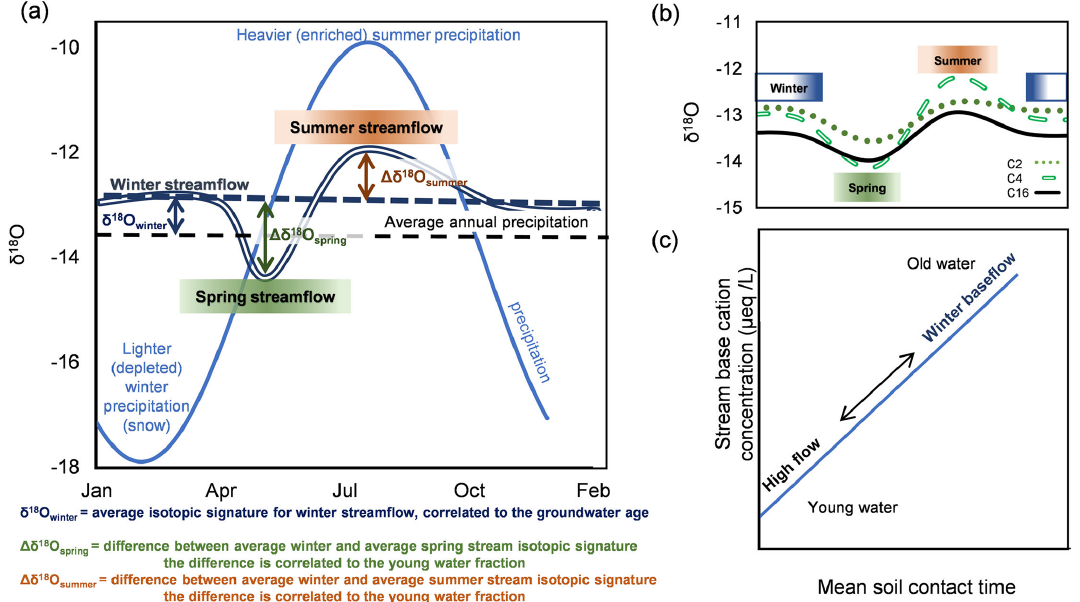
Figure 2. Conceptual figure of travel time to stream vs. stream isotopic signature (a, b) and stream base cation concentration (c) . (a) The connection between δ 18 O and travel time to stream, where the sine curve shows the annual variations of δ 18 O in precipitation, and approximate seasonal winter, spring, and summer stream compositions are marked and exemplified by the average annual changes in C4. In winter, the travel times are related to the average deviation in the isotopic signature between the winter baseflow and the long-term precipitation. In spring, the fraction of young water is correlated with the difference between the average spring stream signature and the average winter baseflow. In summer, the fraction of young water is correlated with the difference between the average summer stream signature and average winter baseflow. (b) Seasonal δ 18 O averages for three example streams: C2, C4 and C16. (c) The connection between base cation (BC) concentration and soil contact time. The longer the water spent in the mineral soil, the higher the stream concentrations of BCs will be due to soil